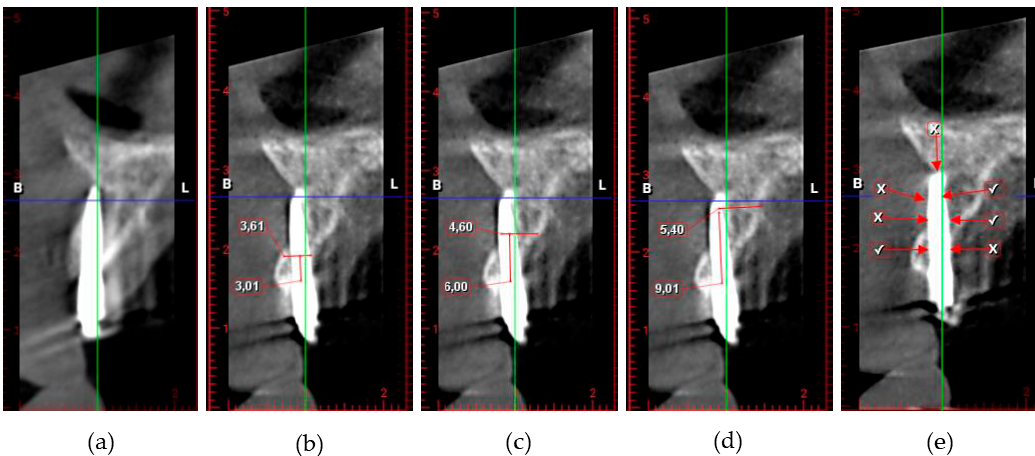
Figure 6. ( a ) CBCT cross sectional view of MDI placed in location 23; ( b ) measurement of bone thickness at 3 mm; ( c ) measurement of bone thickness at 6 mm; ( d ) measurement of bone thickness at 9 mm; ( e ) perforations marked with ( X ) and bone ‐ to ‐ implant contact (BIC) buccal/palatal marked with ( V ).